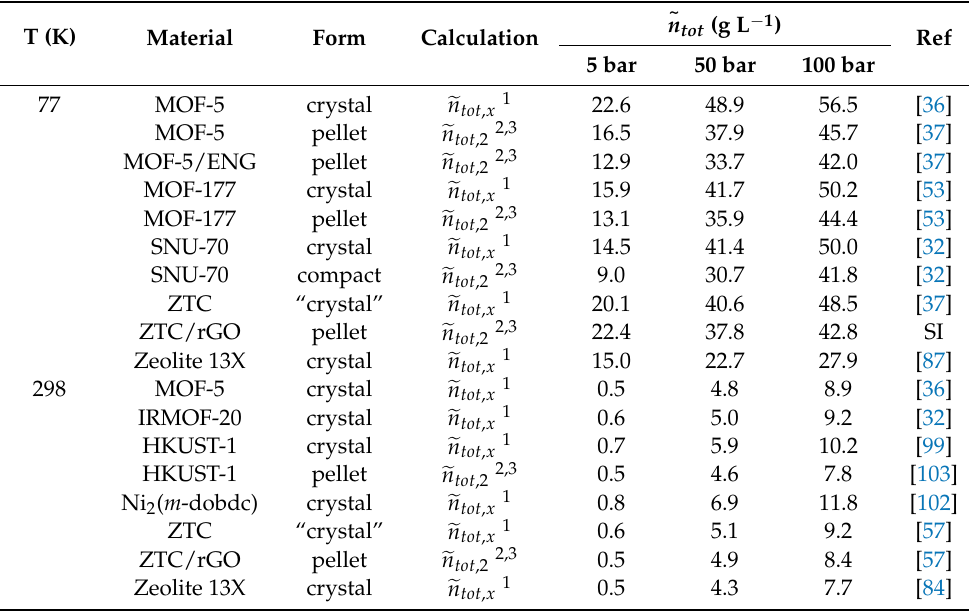
Table 4. Volumetric H 2 storage calculations on selected MOFs, porous carbons, and zeolites at 77–298 K (as shown in Figures 5 and